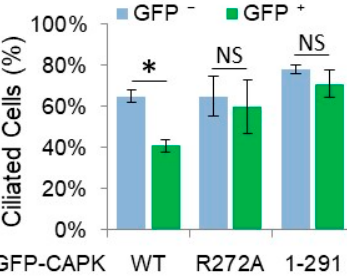
Figure 5. Truncation of the C-terminal domain (CTD) of CAPK impairs its ability to suppress ciliogenesis. GFP-CAPK wild type (WT), loss-of-function mutant (R272A), or CTD-truncated (1–291) proteins were expressed in NIH-3T3 cells. Primary cilia were visualized through immunofluorescence of a ciliary marker, Arl13B. The percentages of ciliated cells in GFP-positive (green bar) and GFP-negative (blue bar) cells were calculated and shown here as mean ± SD, n = 412 cells (WT), 376 cells (R272A), 420 cells (1-291), * P < 0.01, NS = not significant.